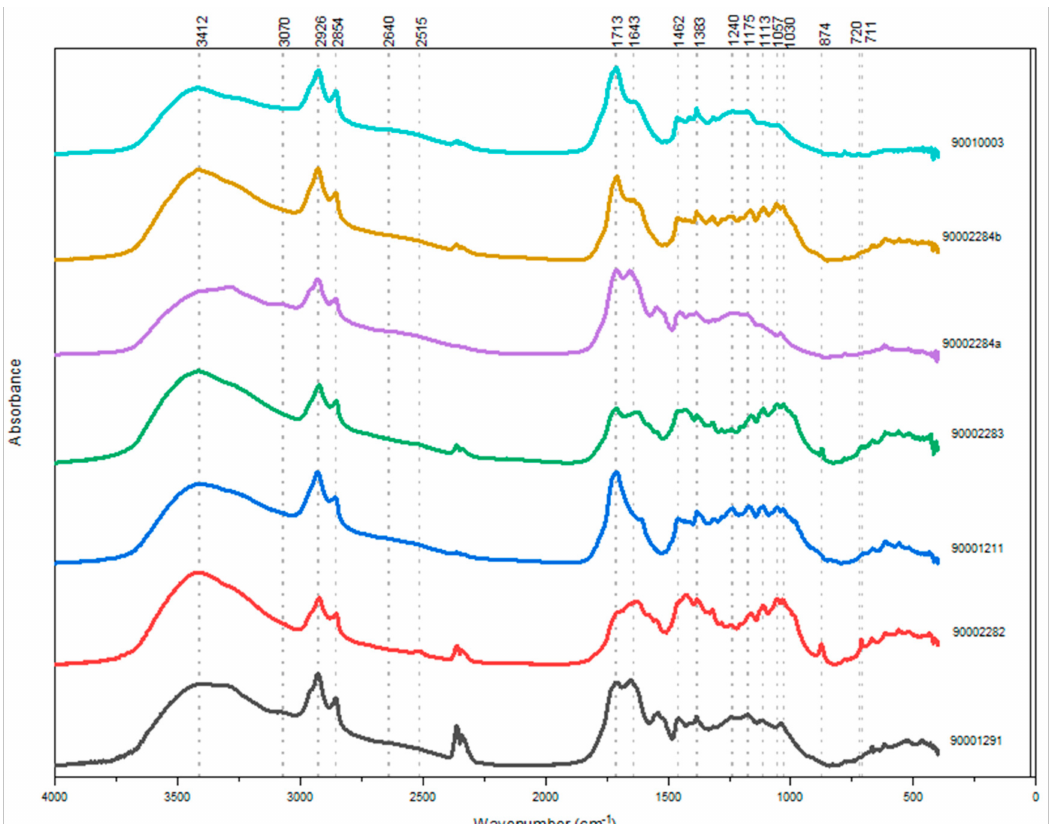
Figure 1. Infrared spectra of analyzed balms sampled from six gazelle mummies from Kom